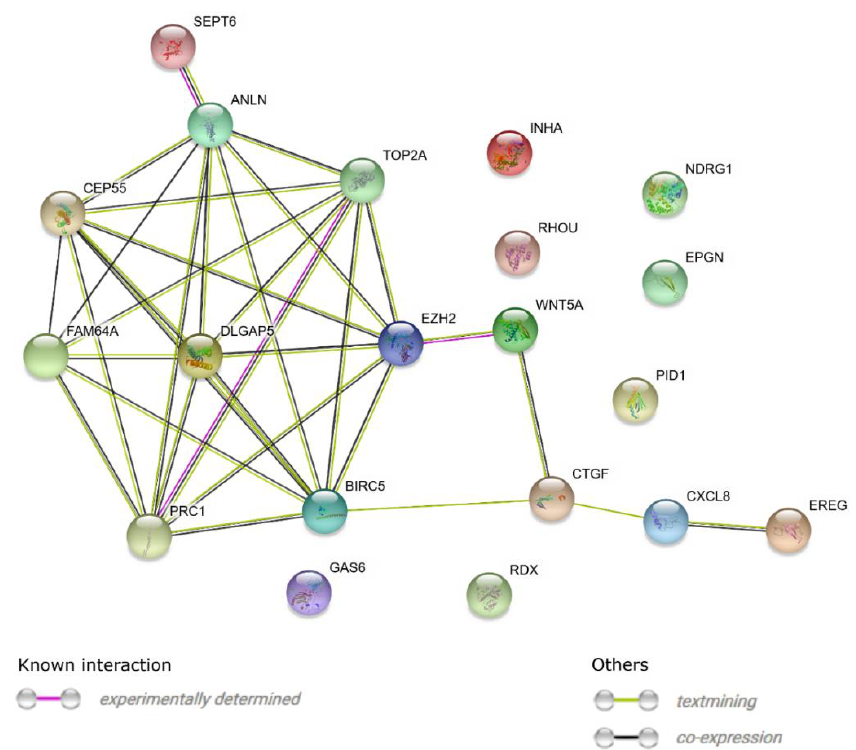
Figure 4. STRING-generated interaction network between the 20 chosen genes belonging to the “cell cycle arrest”, “cell cycle process”, “mitotic spindle assembly checkpoint”, “mitotic spindle assembly”, “mitotic spindle checkpoint”, and “mitotic spindle organization” GO BP terms. The intensity of the edges reflects the strength of the interaction score.